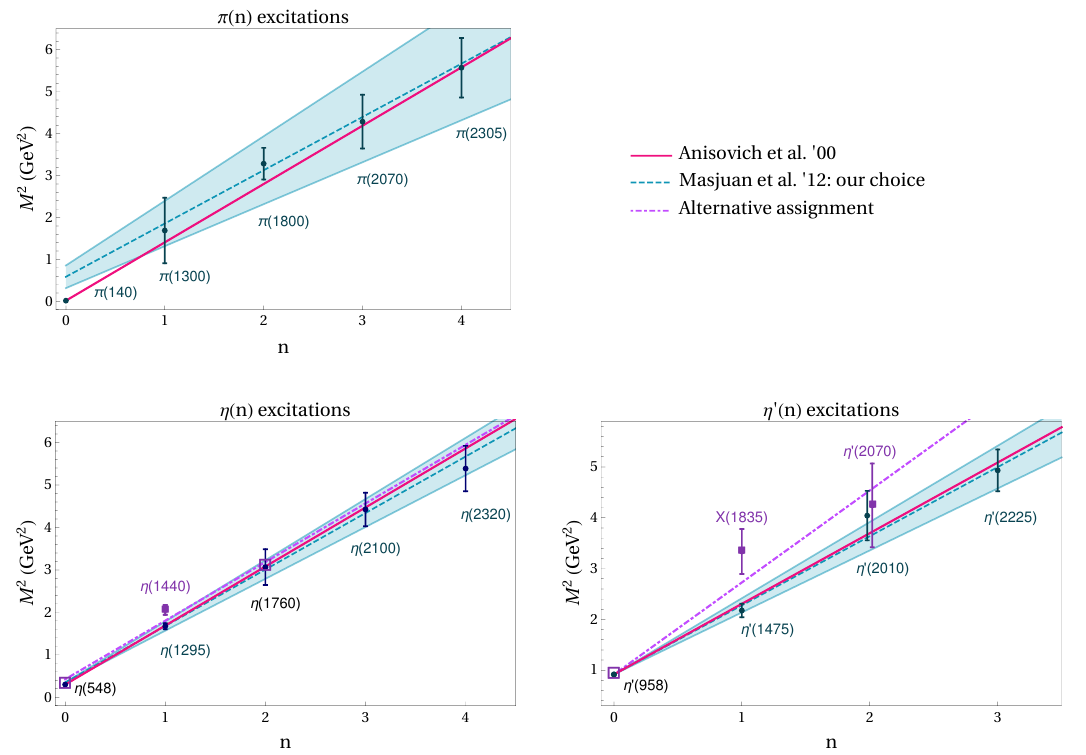
Figure 6. Radial Regge trajectories of the (cid:25) , (cid:17) , and (cid:17) 0 pseudoscalar mesons. The states (cid:25) (140), (cid:25) (1300), (cid:25) (1800), (cid:17) (548), (cid:17) (1295), (cid:17) (1760), (cid:17) 0 (958), (cid:17) 0 (1475), X (1835), and (cid:17) 0 (2225) are from PDG [90]. Note that the states (cid:17) (1760), X (1835), and (cid:17) 0 (2225) are omitted from the PDG summary tables. The state (cid:17) (1440) is from PDG ’00 [112]. The states (cid:25) (2070), (cid:25) (2305), (cid:17) (2100), (cid:17) (2320), and (cid:17) 0 (2010) are extracted from ref. [108]. The state (cid:17) 0 (2070) is taken from [113, table 26]. The errors are de(cid:12)ned as (cid:1) M 2 = (cid:0) M [108]. The solid magenta lines are (cid:12)ts from ref. [109]: (cid:27) 2 = (cid:27) 2 = (cid:25) (cid:17) (cid:27) 2 = 1 : 39 GeV 2 . The turquoise bands are (cid:12)ts from ref. [108] which exclude the ground states of (cid:17) 0 the pion and the (cid:17) : (cid:27) 2 = 1 : 27(27) GeV 2 and ^ M (cid:25) = 766 MeV as in (4.9), (cid:27) 2 = 1 : 33(11) GeV 2 and (cid:25) (cid:17) ^ M 2 = 1 : 36(14) GeV 2 . The (cid:17) (1440), X (1835), and (cid:17) 0 (2070) states (cid:17) = 591 MeV as in (4.38), and (cid:27) (cid:17) 0 (purple squares) correspond to a di(cid:11)erent assignment of (cid:17) ( 0 ) excitations suggested in ref. [113, table 27]. The dot-dashed purple lines correspond to our (cid:12)ts of these alternative trajectories: (cid:27) 2 = 1 : 38 GeV 2 with ^ M (cid:17) = 0 : 652 GeV, and (cid:27) 2 = 1 : 81 GeV 2 (cid:17) (cid:17) 0